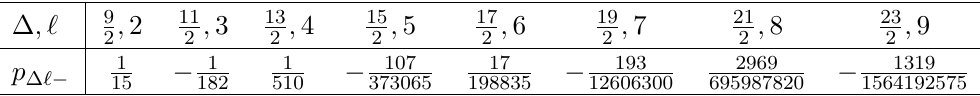
Table 5 . OPE coefficients for parity odd operators in the conformal block decomposition of JφJ ¯ φ and φJJ ¯ φ